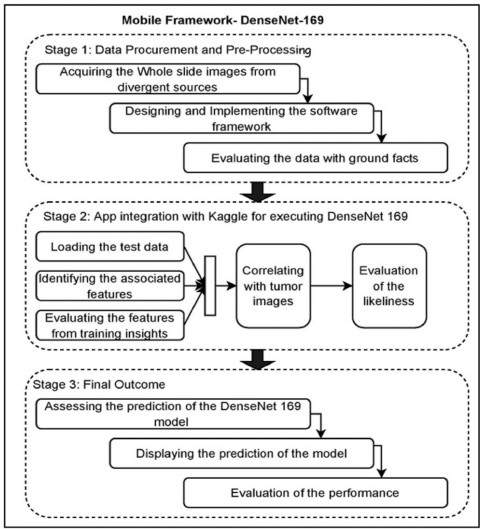
Figure 17. Mobile framework for app integration with fine-tuned DenseNet-169.